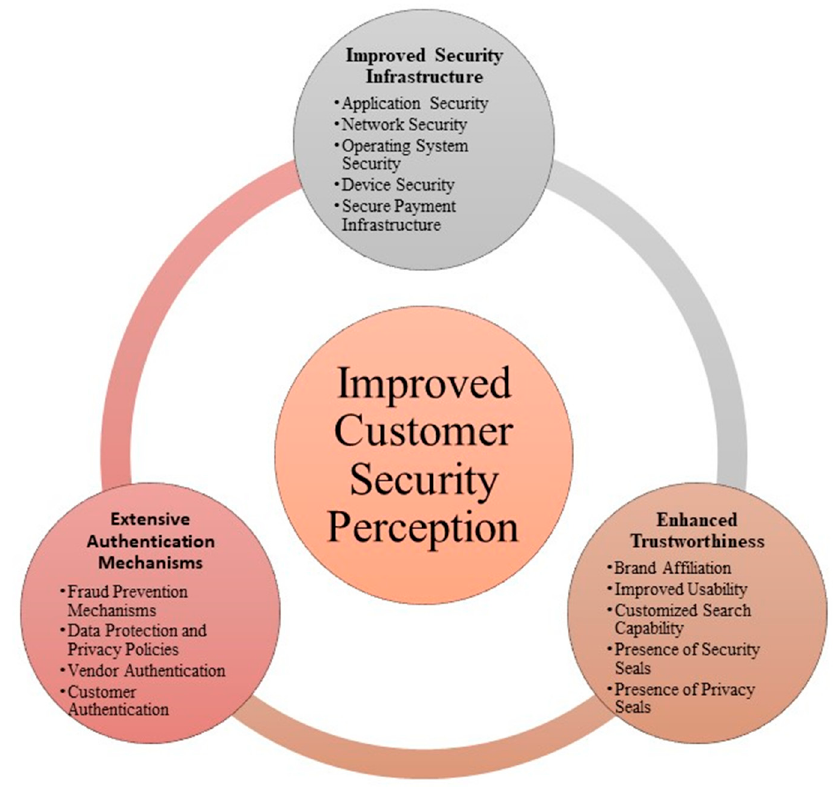
Figure 9. Improved customer security perception.